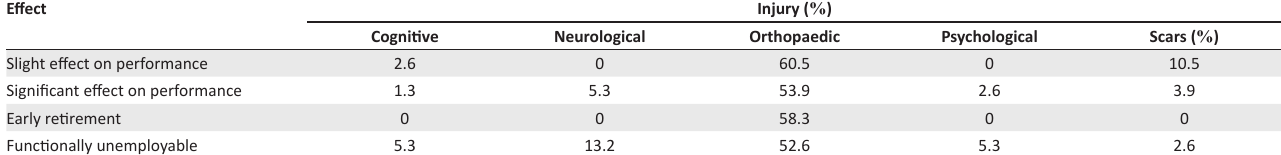
TABLE 4a: Cross tabulation of type of injuries victims sustained and their influence on careers and performance.